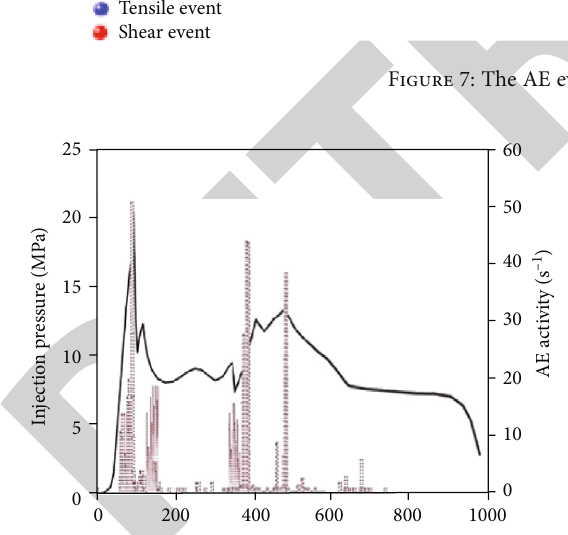
Figure 7: The AE event distribution of Sample 3#.